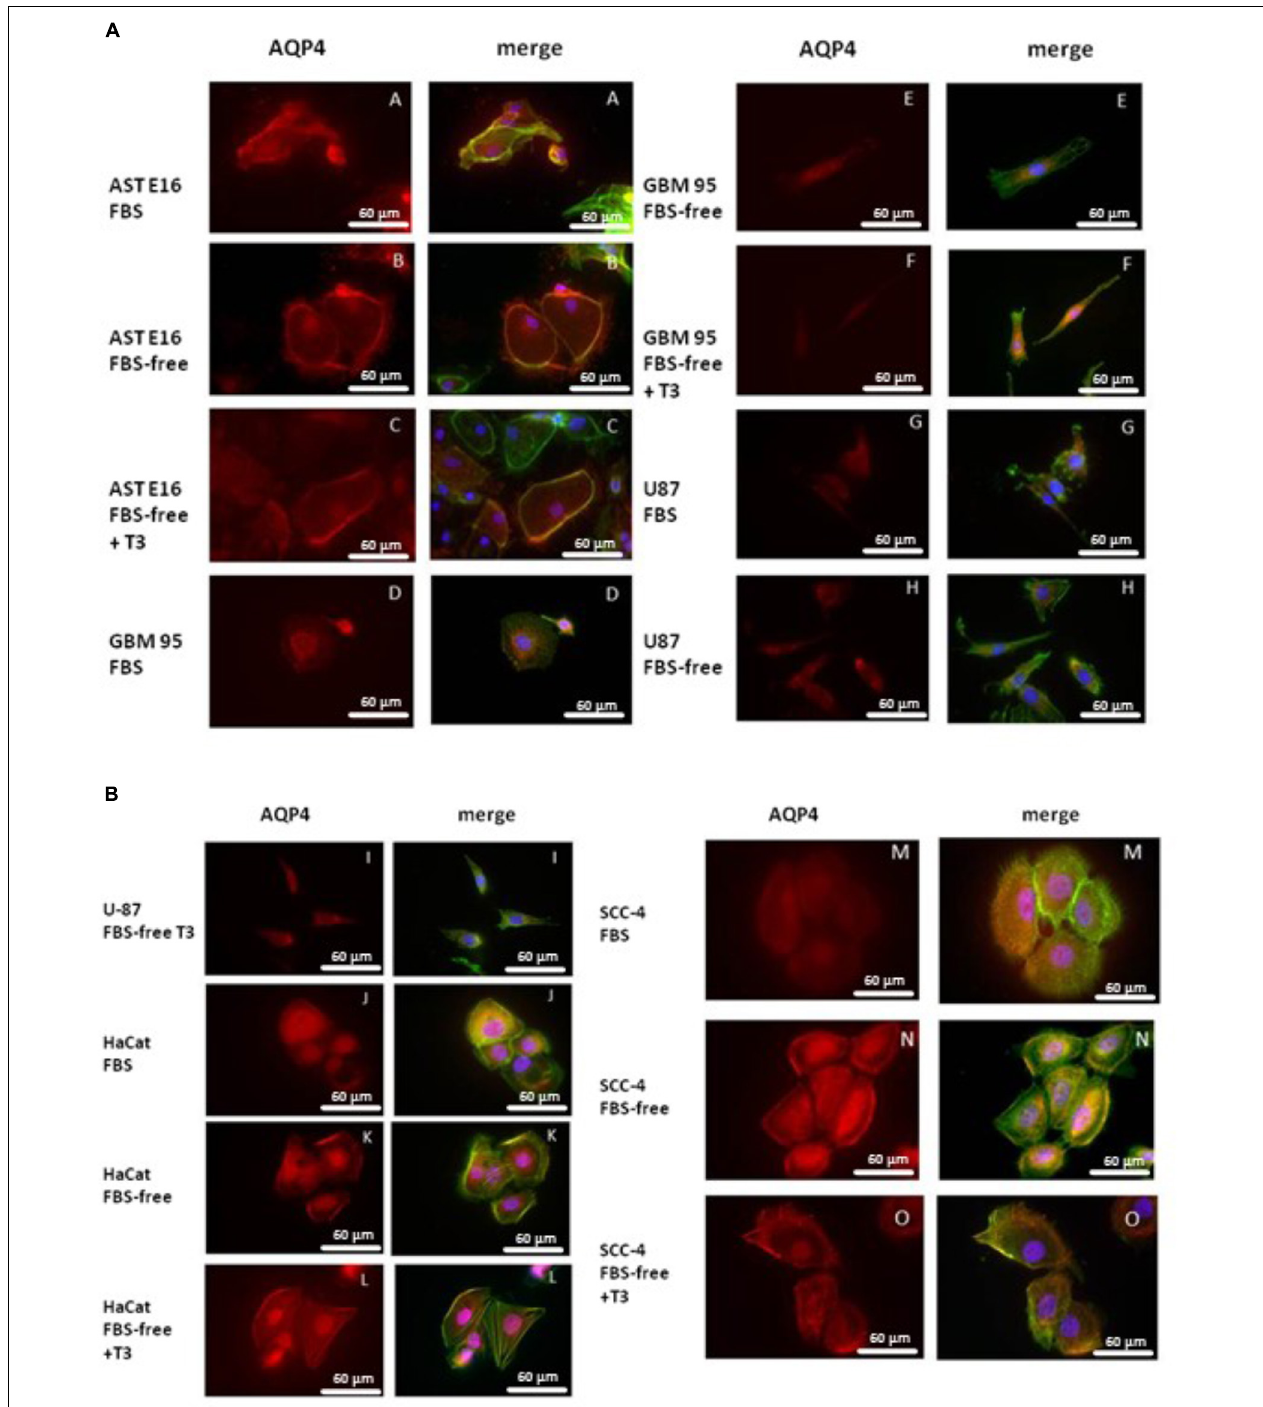
FIGURE 5 | (A) Immunofluorescence staining for AQP4 (red) and phalloidin (green) or DAPI (blue). T3 treatment (50 mM) negatively regulated AQP4 expression only in GBM-95 cells when compared to AQP4 expression in cells maintained in FBS, as shown in Figure 6 . Cells were cultured in medium containing 10% FBS, medium without serum (FBS-free), and treated with T3 in medium without serum (FBS-free+T3). (B) Immunofluorescence staining for AQP4 (red) and phalloidin (green) or DAPI (blue). HaCat, SCC-4, and U87 cell lines treated with T3 (50 mM) showed no change in AQP4 expression.